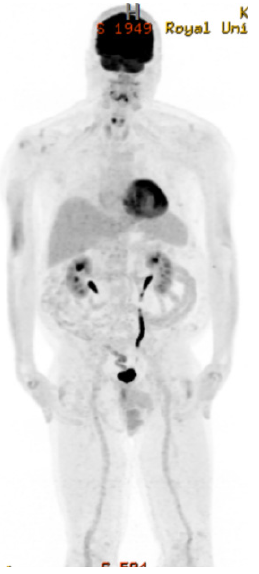
Figure 5. PET in February 2021 showing complete remission.